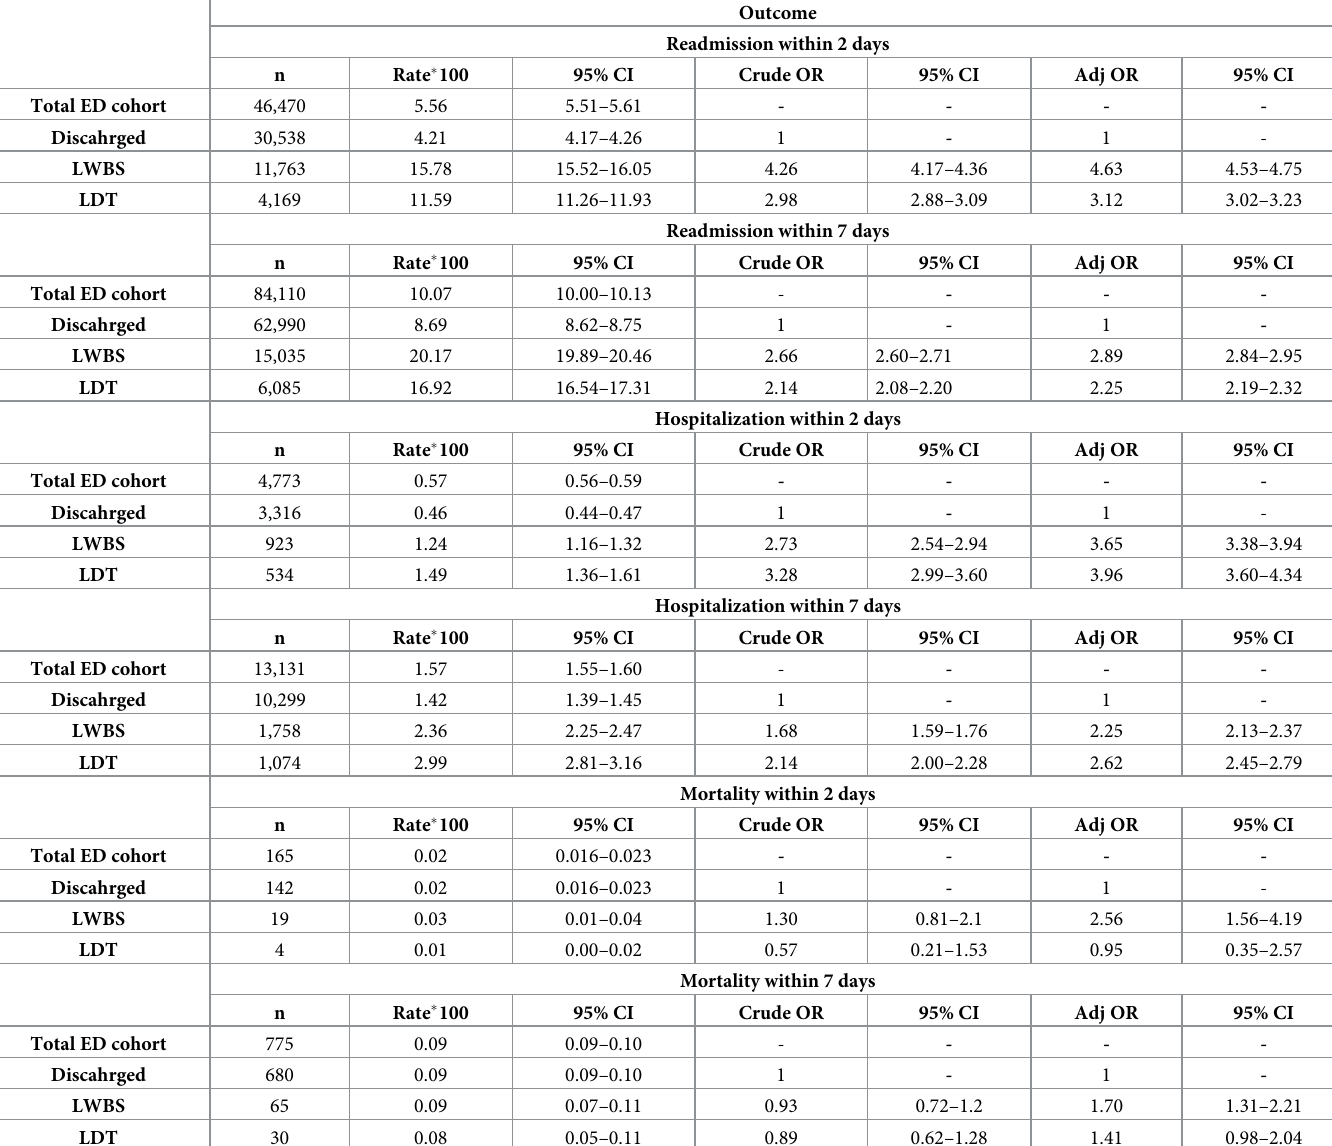
Table 4. Associations between leaving ED (LWBS and LDT) and readmission, hospitalization and mortality within 2 and 7 days: Crude Rate (Rate � 100), Crude Odds Ratio (Crude